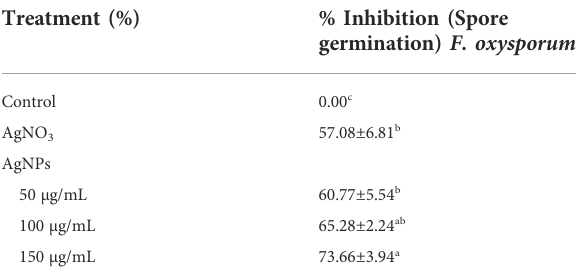
TABLE 2 Inhibition activity of AgNPs on spore germination of F. oxysporum